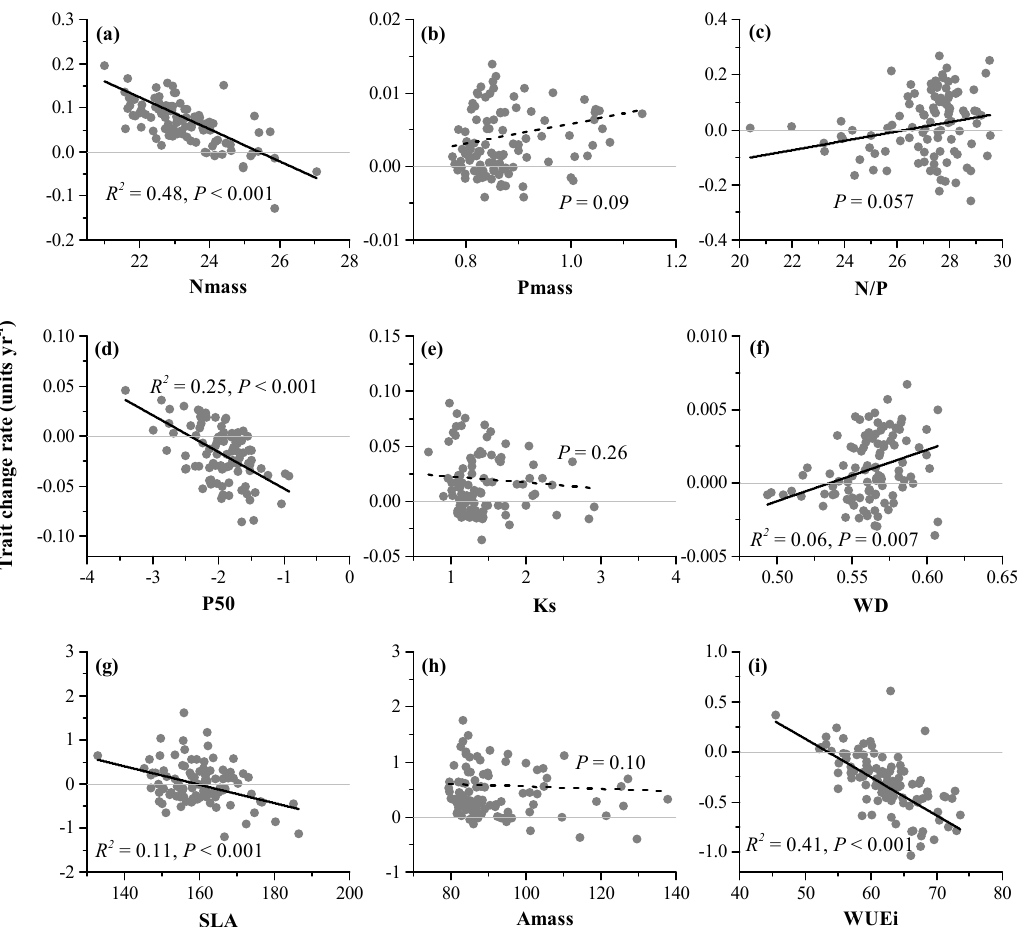
Figure 3. Linear regression between quadrats’ initial trait values and subsequent change rates (1992–2015) in DHS plot. (a) leaf nitrogen concentration per unit mass (Nmass, mg g − 1 ); (b) leaf phosphorus concentration per unit mass (Pmass, mg g − 1 ); (c) leaf nitrogen to phosphorus ratio per unit mass (N/P,); (d) the pressure causing 50% loss of stem hydraulic conductivity (P50, MPa); (e) sapwood-specific hydraulic conductivity (Ks, kg m − 1 s − 1 MPa − 1 ); (f) sapwood density (WD, g cm − 3 ); (g) specific leaf area (SLA, cm 2 g − 1 ); (h) maximum CO 2 assimilation rate per unit mass (Amass, nmol g -1 s -1 ); (i) instantaneous photosynthetic water-use efficiency (WUEi, μ mol mol − 1 ).